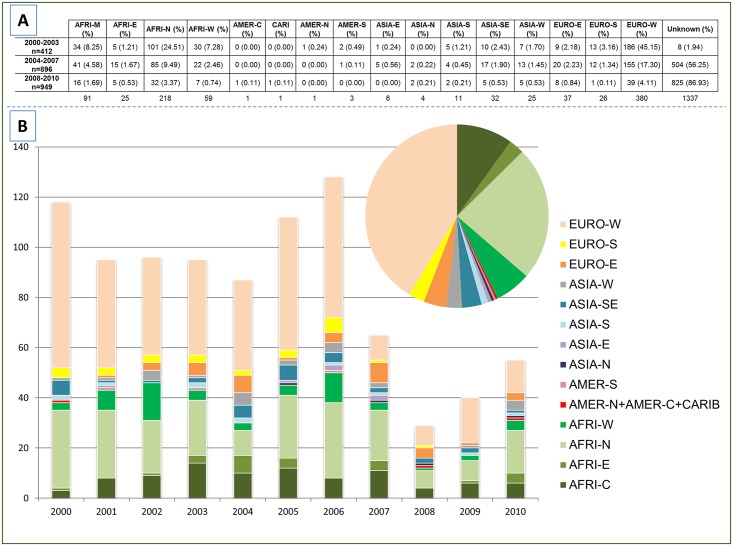
Number of patients considering their subregion of origin per groups of year (A); and per year of study (from 2000–2010) (B).Note that although 927 patients were known to be foreign-born (as shown in Table 2), the exact geographical origin allowing to classify them in a specific UN subregion lacked for 7 of 927 foreign-born patients.